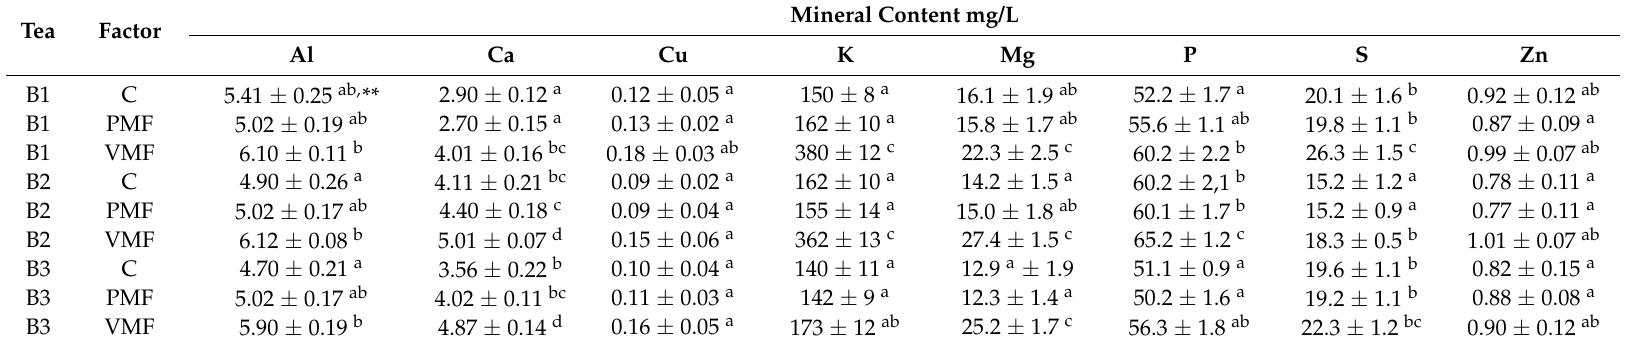
Table 1. Analytical findings showing contents of selected chemical elements in black tea infusions extracted with the use of a magnetic field under control conditions. Tea